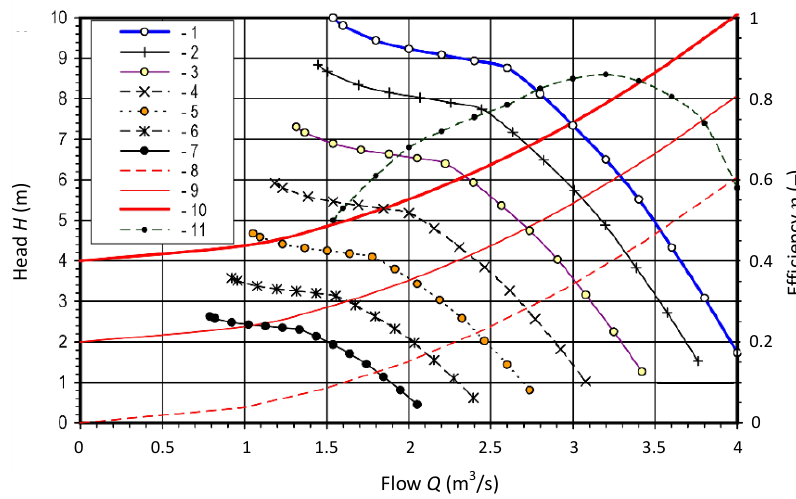
Figure 4. Efficiency and head waveforms as a function of the vertical pump OB 16-87 capacity. The waveforms 1 – 7 are plotted for the speeds: 585, 550, 500, 450, 400, 350, and 300 rpm, respectively. Waveforms 8, 9, and 10 represent the pipeline heads: H g = 0 m; H g = 2 m; and H g = 4 m, and the pump’s capacity is represented with 11.